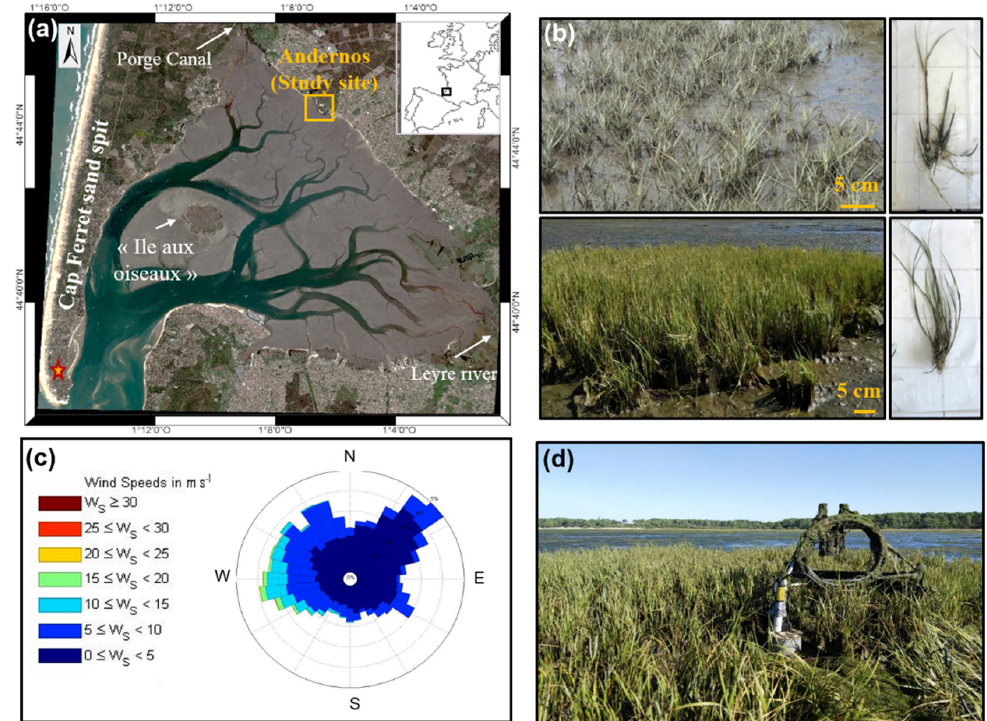
Figure 1. ( a ) Location of the study site of Andernos (yellow box) within the Bay of Arcachon. Red/yellow star indicates the location of the Cap Ferret’s meteorological station. ( b ) Characterization of Spartina anglica meadow (top left) and individual plant (top right) and Spartina maritima meadow (bottom left) and individual plant (bottom right). ( c ) Wind rose for wind records at the meteorological station of Cap Ferret indicated in ( a ) during the period of the field experiment. ( d ) ALTUS device mounted on a structure installed within Spartina maritima vegetation